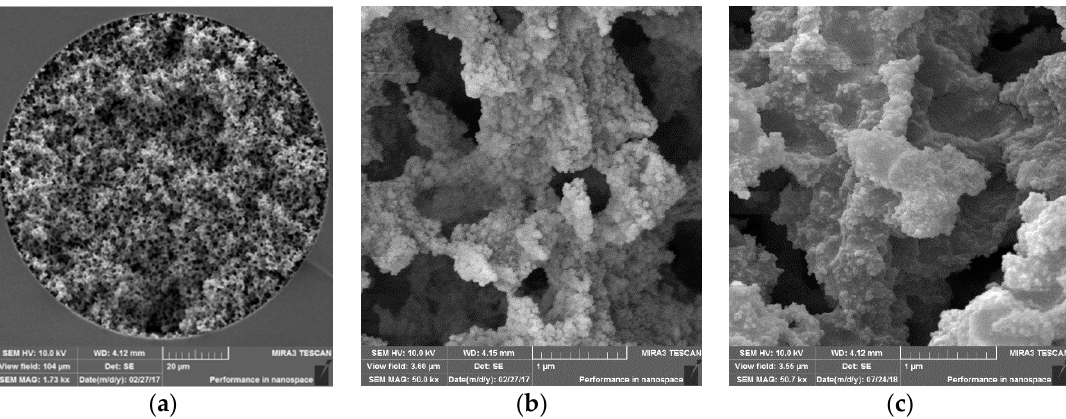
Figure 2. Scanning electron microphotographs of prepared monolithic columns. ( a ) detail of the plain silica monolithic capillary column; ( b ) unmodified monolithic silica skeleton; ( c ) monolithic silica skeleton modified by four coating layers of MSA.